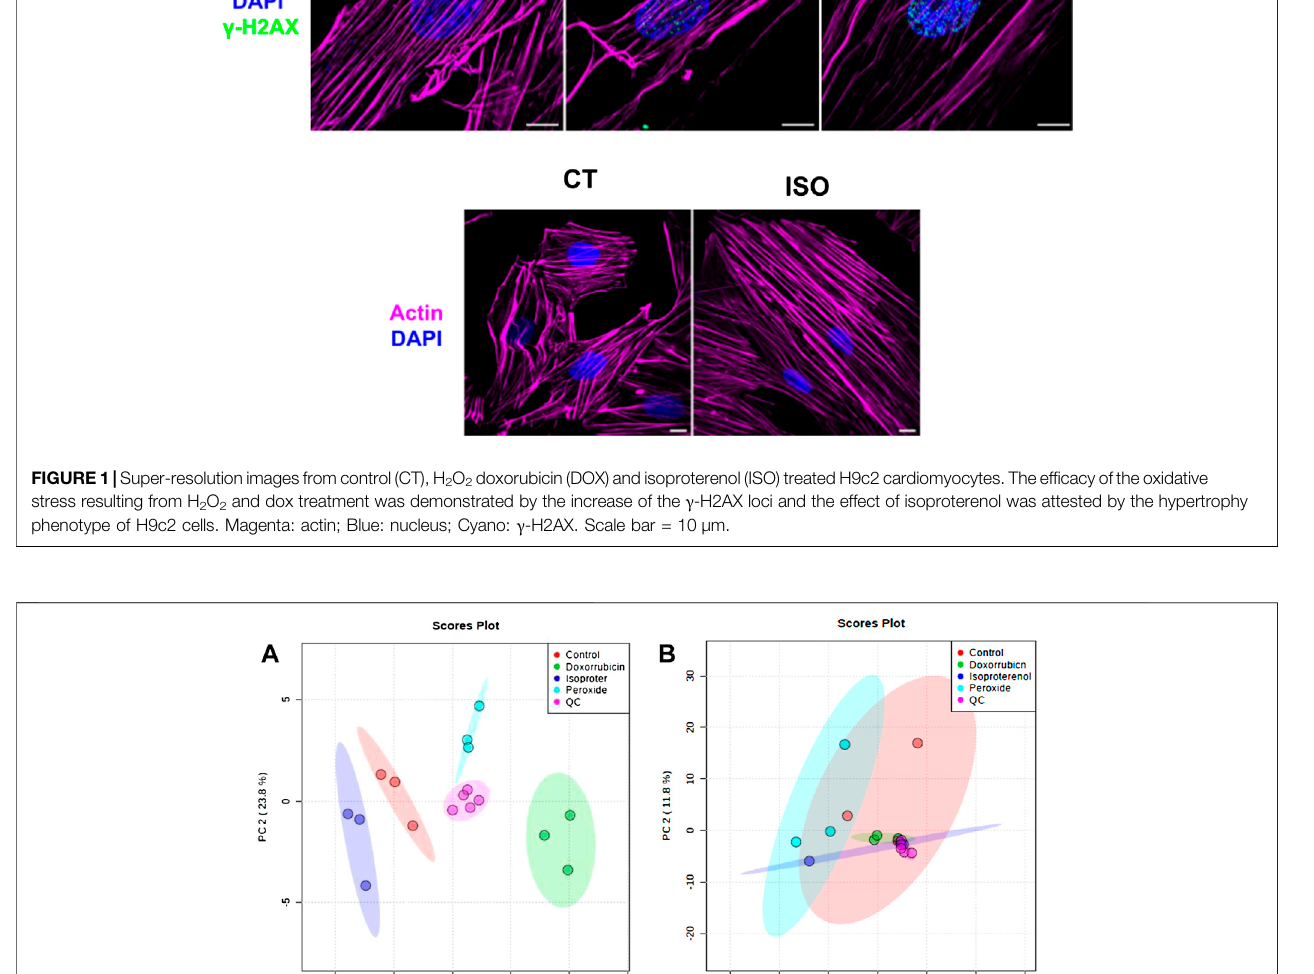
Frontiers in Molecular Biosciences |